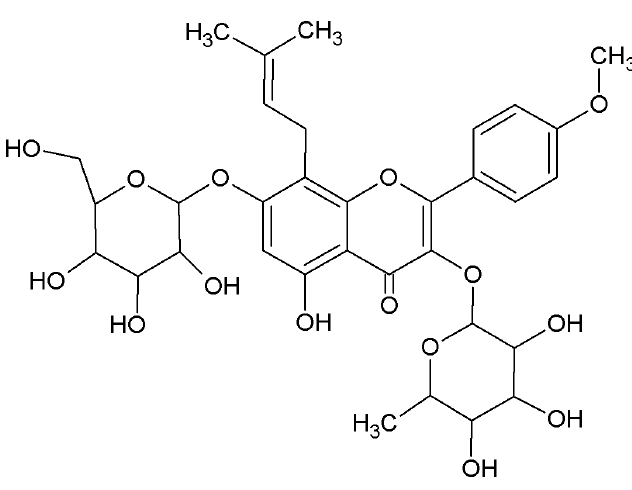
Figure 1. Chemical structure of